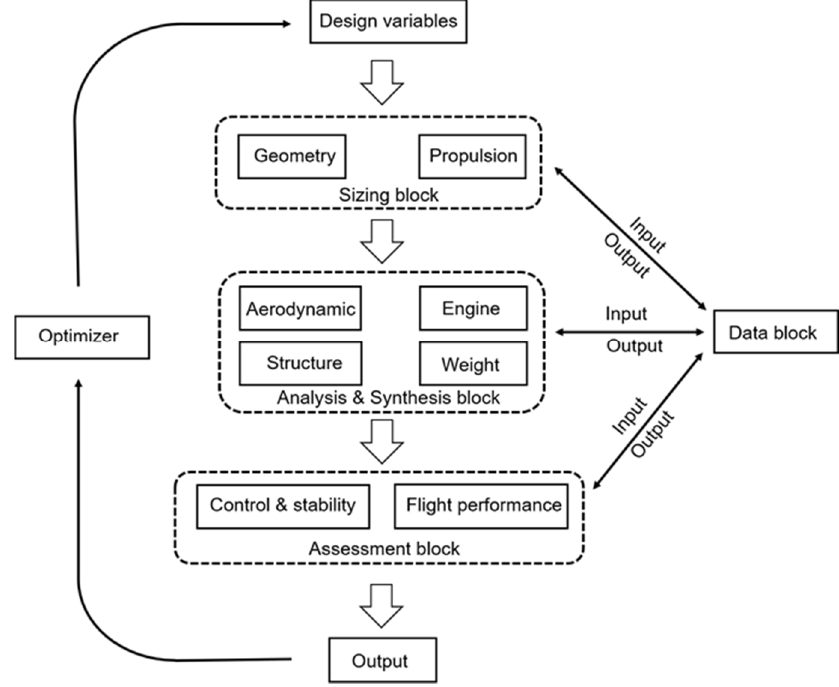
Figure 9. Block and structure of ACADO .